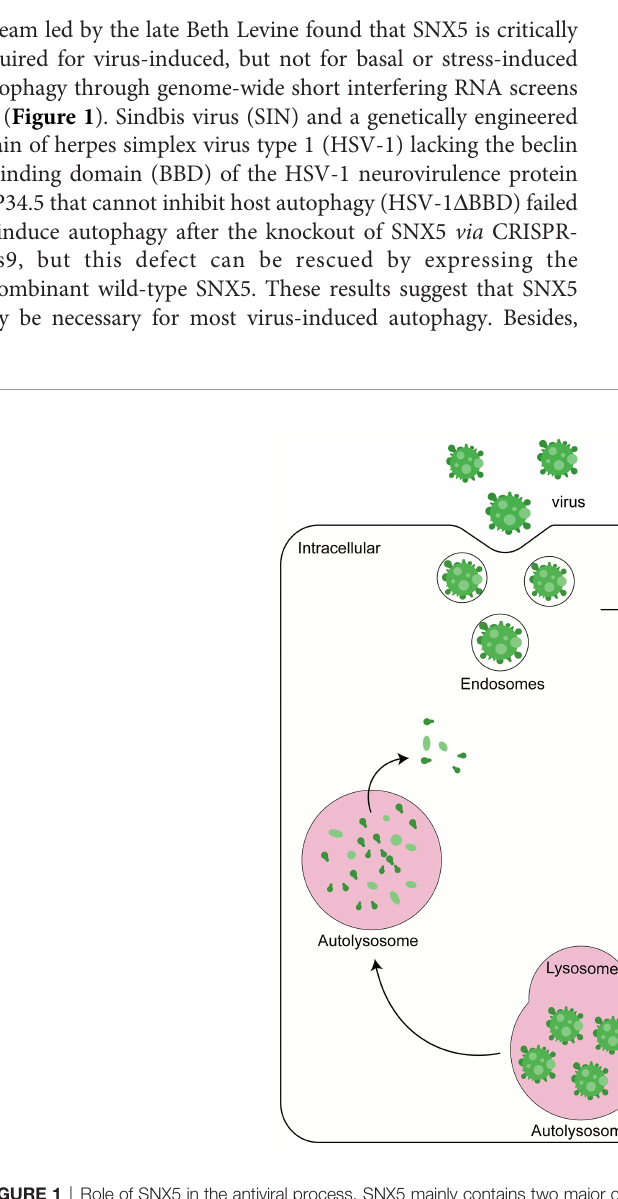
FIGURE 1 | Role of SNX5 in the antiviral process. SNX5 mainly contains two major domains: phox (PX) domain and BAR domain. PX domain mainly recognizes the sorting motif of cargo and binds to phosphatidylinositol-3-phosphate (PtdIns (3)P) or PtdIns (3,4)P2 to regulate the localization of SNX5 to the autophagosome membrane. SNX5-BAR domain mediates the biogenesis of cargo transport carriers and plays an essential role to sense and drive membrane bending. Therefore, SNX5 can promote the virus ’ s clearance, reduce the virus ’ s susceptibility and lethality to host cells and inhibit virus replication in an autophagy-dependent